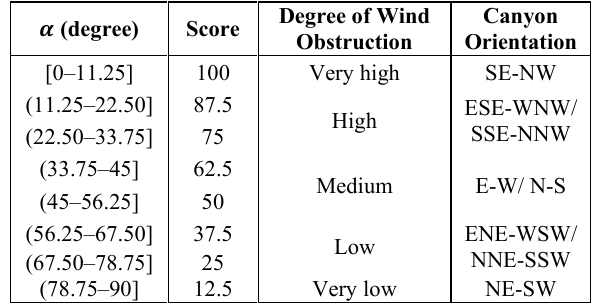
Table 1. Allocated wind obstruction score based on the angle and the canyon orientations for the SW wind direction